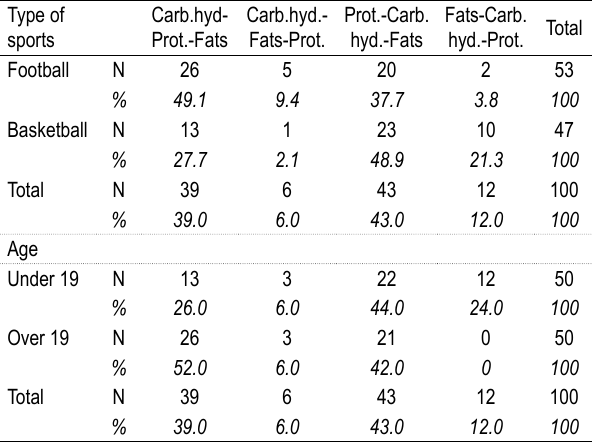
FIGURE 3. Time of consumption of the last meal prior to the training, depending on age and type of sports TablE 1. Macronutrients per importance in nutrition depending on age and type of sports